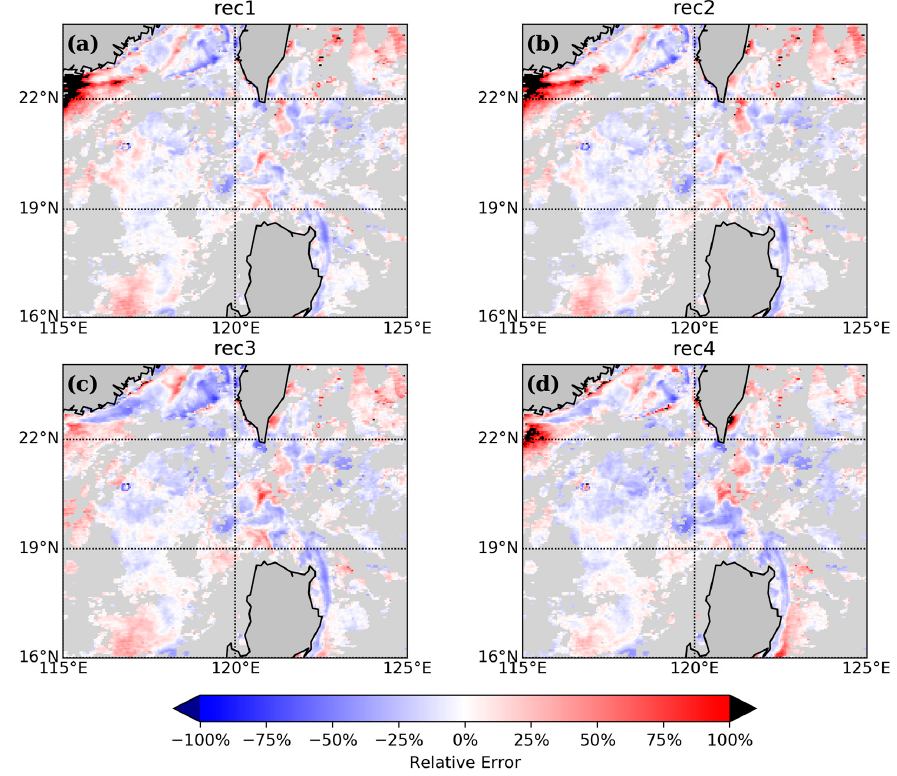
Figure 11. Spatial distribution of relative error, (Chl- a rec -Chl- a sat ) / Chl- a sat for 17 May 2018.